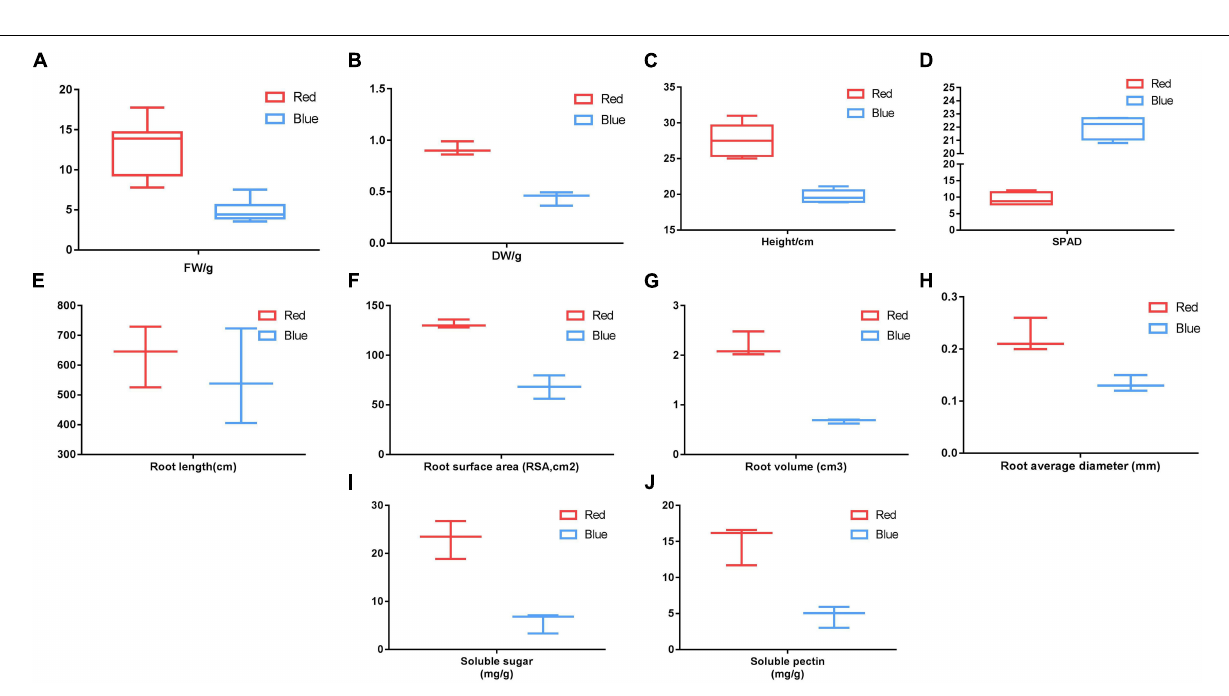
FIGURE 2 | Comparison of plant growth and development, soluble sugar, and soluble pectin under the red and blue lights. (A–J) Indiated the fresh weight, dry weight, plant height, SPAD, root length, root surface area, root volume, root average diameter, soluble sugar, and soluble pectin, respectively. FW: fresh weight; DW: dry weight; SPAD, soil and plant analyzer